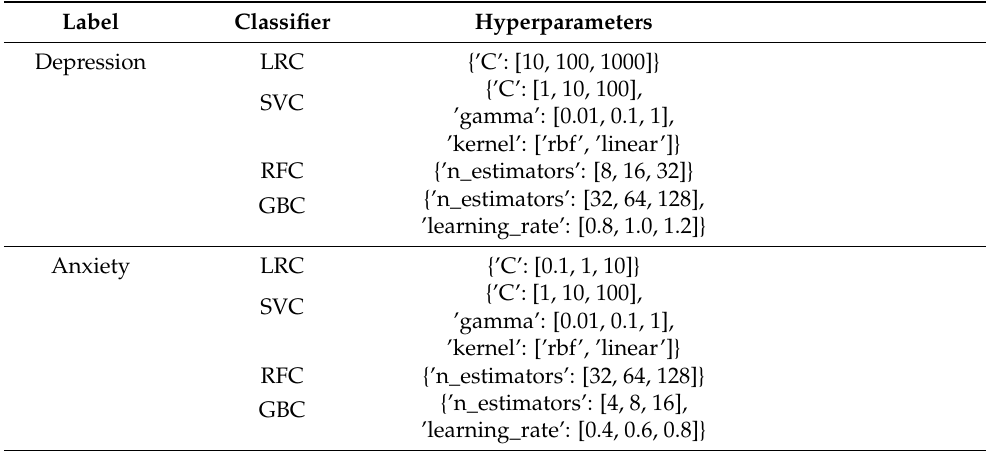
Table 6. Hyperparameters for classification using both activity tracking and minimal assessment